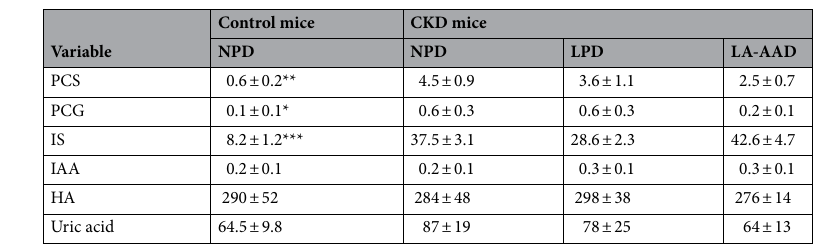
Table 4. Serum concentration of total uremic toxins (µmol/L). Data are expressed as mean ± SEM. CKD Chronic kidney disease, PCS P-cresyl sulfate, PCG p-cresyl glucuronide, IS Indoxyl sulfate, IAA Indole-3- acetic-acid, HA Hippuric acid, NPD Normoproteic diet, LPD Low protein diet, LA-AAD Low aromatic amino- acids diet. * p < 0.05; ** p < 0.01; *** p < 0.001 versus CKD-NPD (ANOVA and Dunnett post hoc test).